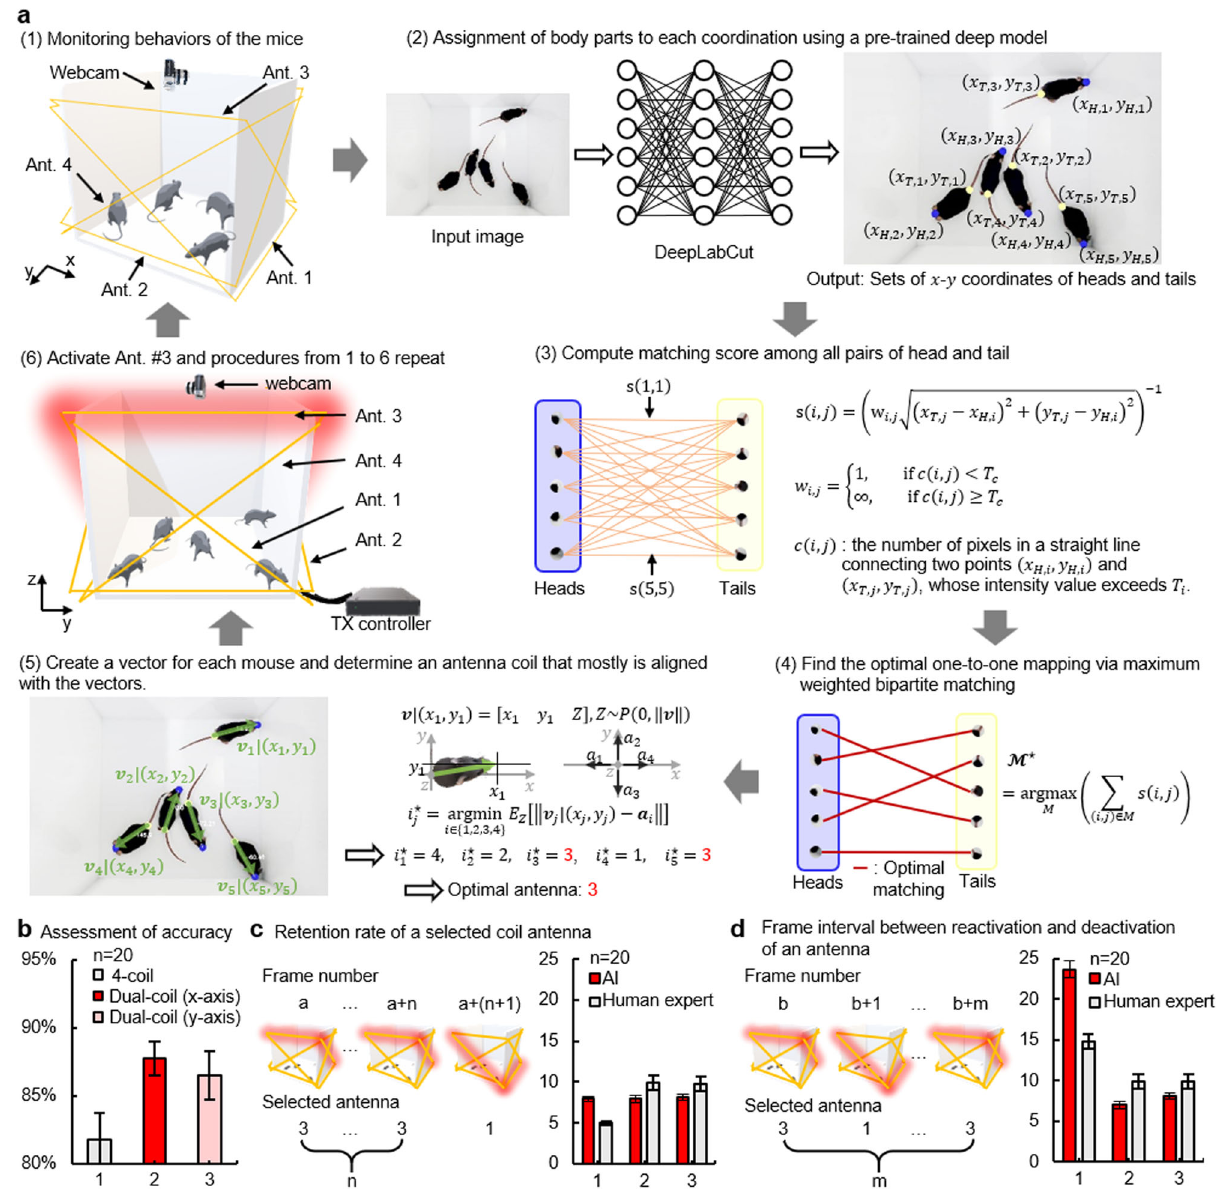
Fig. 3 Real-time identi fi cation of the optimal coil antenna based on the pose estimation of multiple animals via DLC. a Illustration of step-by-step procedures for the proposed algorithm. b Assessment of detection accuracy for three different antenna structures: (1) 4-coil (each two coil antennas are on the x- and the y -axis, respectively), (2) Dual-coil (along the x-axis), and (3) Dual-coil (along the y-axis). Statistics of the number of frames for two representative cases. c How long a selected antenna remains activated. d How many frames (how long an interval) exist between activation of an antenna and reactivation of itself after the fi rst deactivation; Data are presented as mean values ±